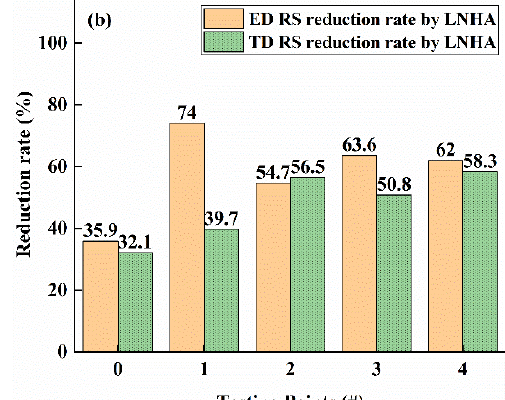
Figure 4. ( a ) ED and TD residual stress and ( b ) relief rate at different points treated by LNHA.